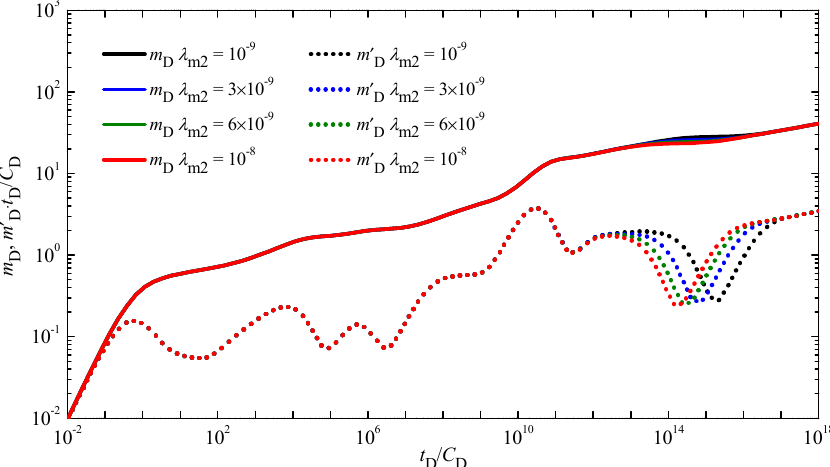
Figure 7. Influence of the outer–zone matrix–fracture interporosity flow coefficient on the pressure type curve.